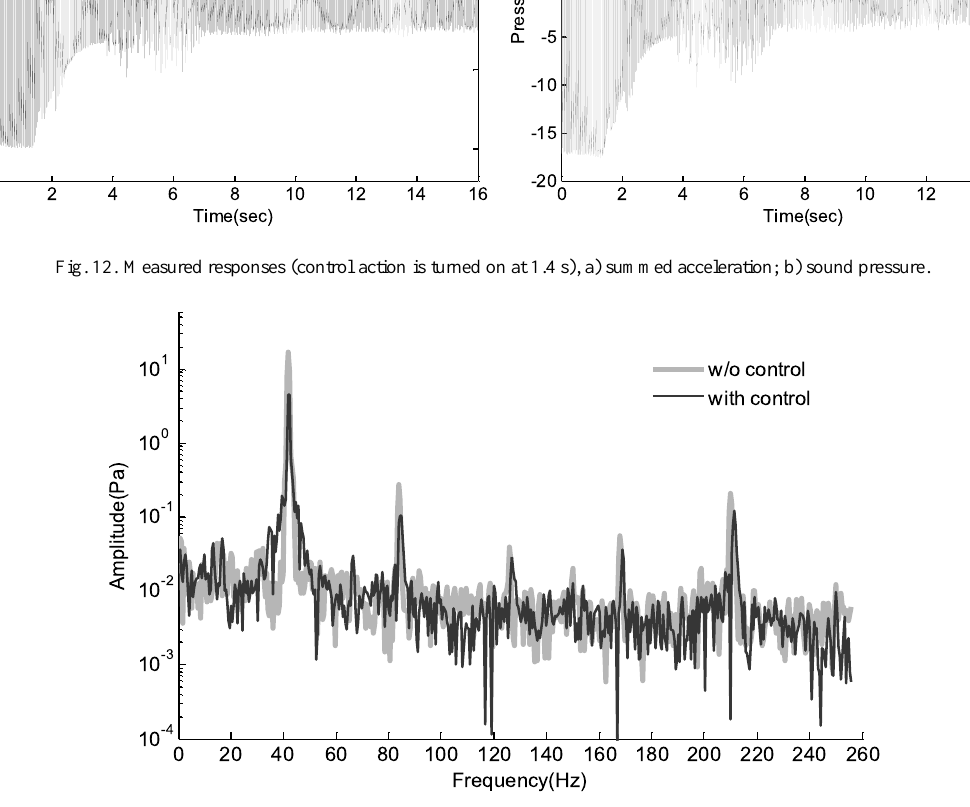
Fig. 13. Sound spectra before and after